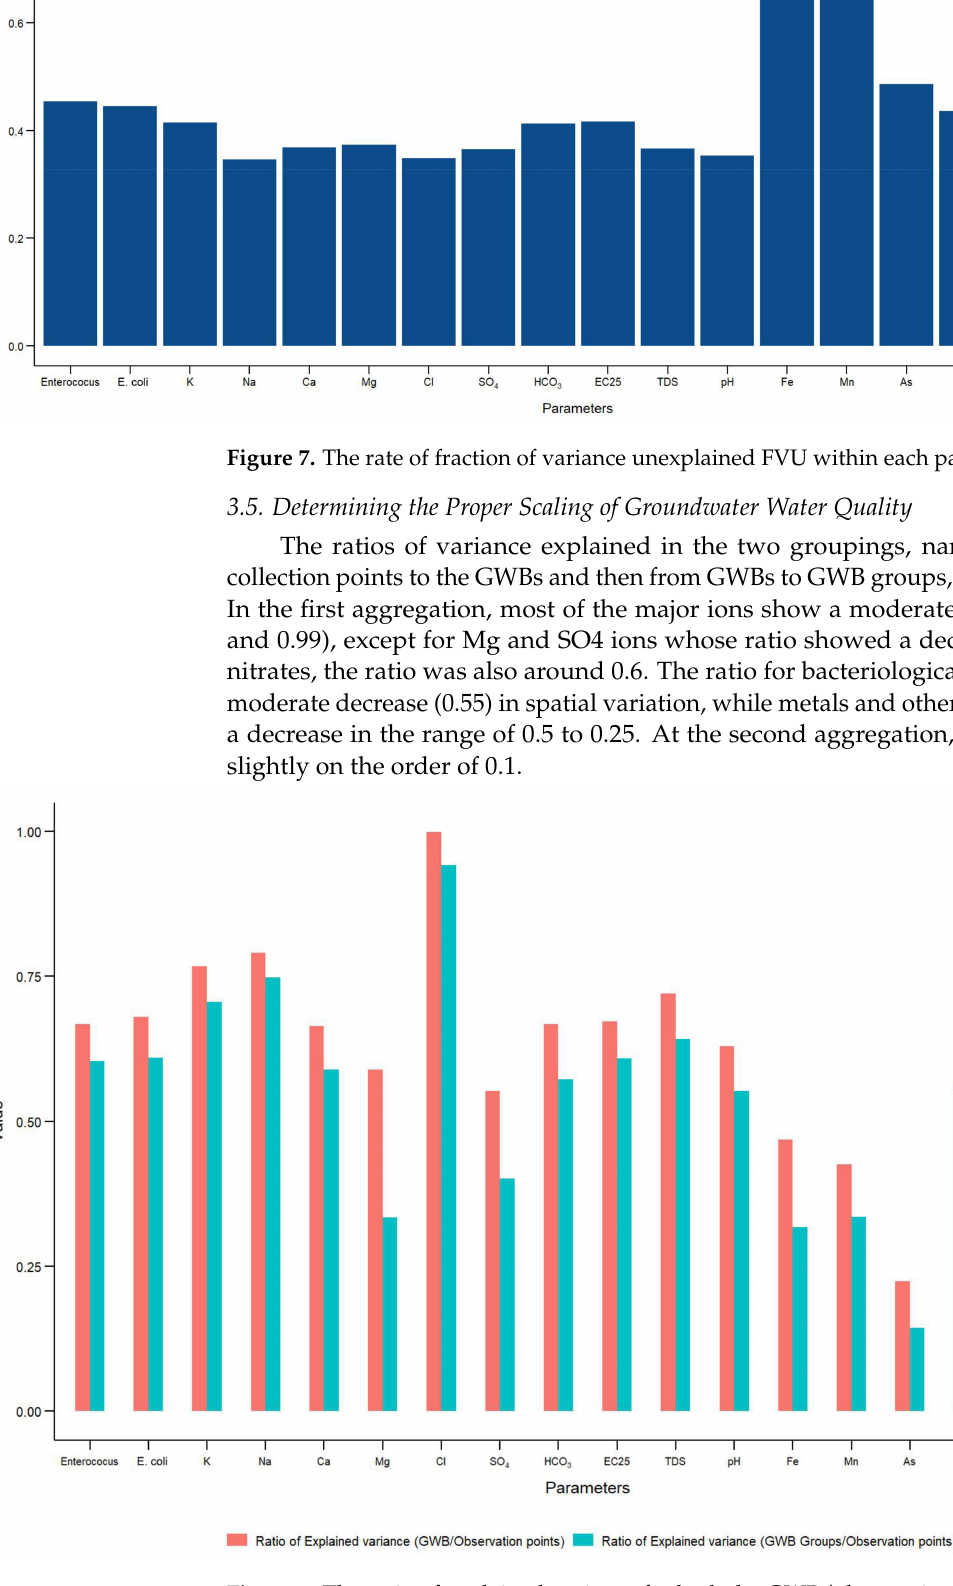
Figure 8. The ratio of explained variance for both the GWB/observation point scale and the GWB groups/observation point